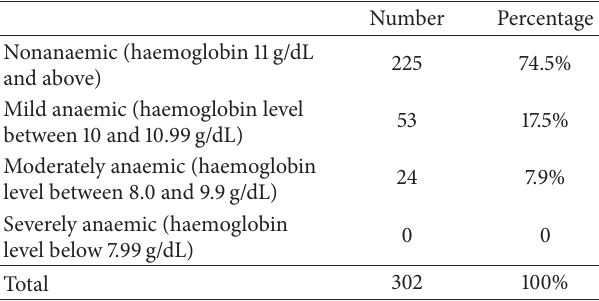
Table1:Proportionofparticipantswiththefoursetsofclassification of